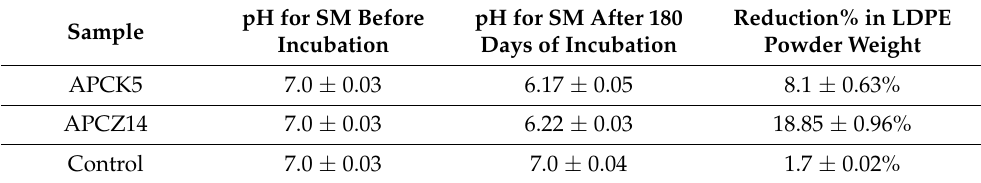
Table 3. Changes in pH values of the media and reduction percentage in LDPE weight.